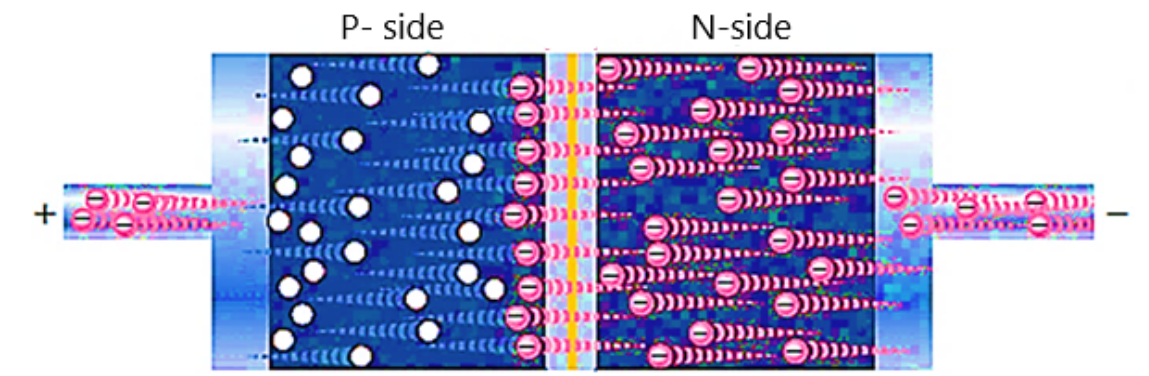
Figure 3. The basic semiconductor form at the instant connection of the p-n sections and generating the electric field in the space charge region.